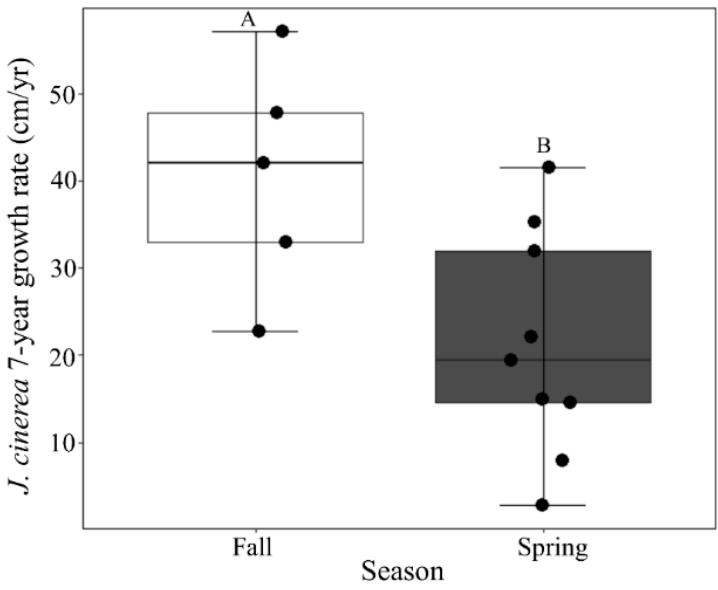
Figure 6. Growth rates of J. cinerea over seven years as measured in 2019 for seedlings planted in a temperate forest understory in southwestern Ohio, USA, during a forest restoration experiment. Seedlings that were planted in the fall are represented by white boxes and growth rates for those planted in spring are represented by the dark grey box. The middle line in the box is the median, individual points represent seedlings, and letters represent statistically significant differences between the means ( p = 0.022).